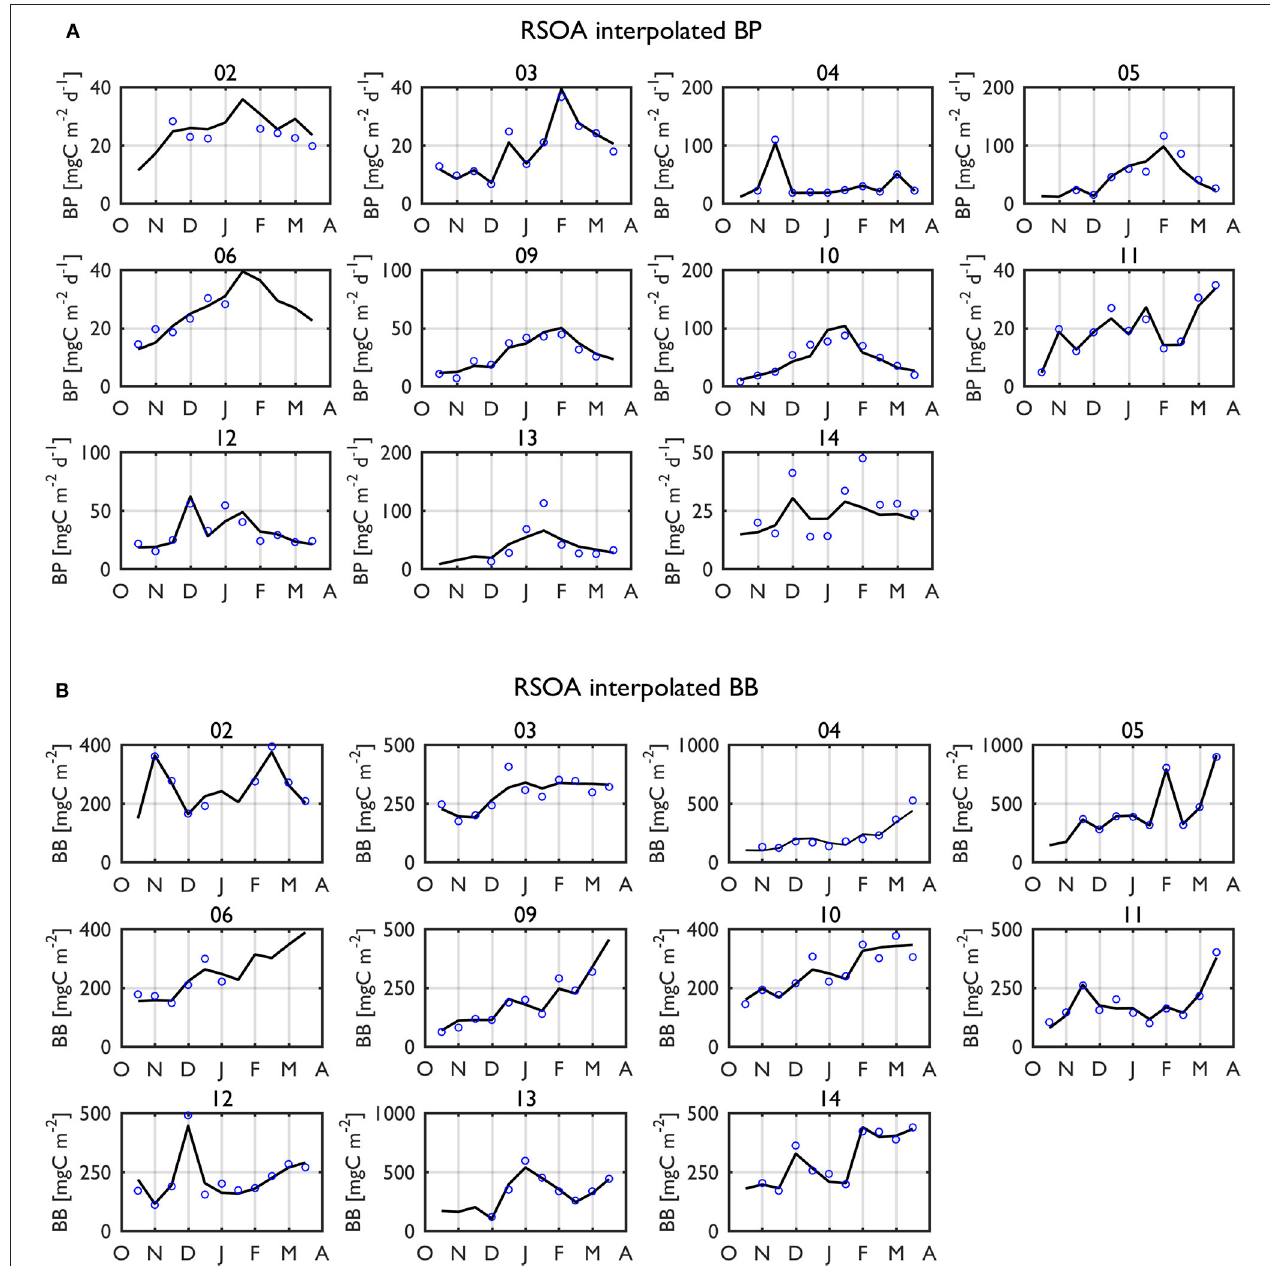
FIGURE 6 | Interpolated (black solid line) BP rates (A) and BB standing stocks (B) in the upper 50-m using the first 4 and 5 dominant EOF modes, respectively (i.e., RSOA interpolation) for individual years over entire growing seasons. The blue dots indicate 15-d means of measured values of BP and BB. Year annotations indicate the starting year of the austral growing season (i.e., 02 for October 2002 to March 2003).